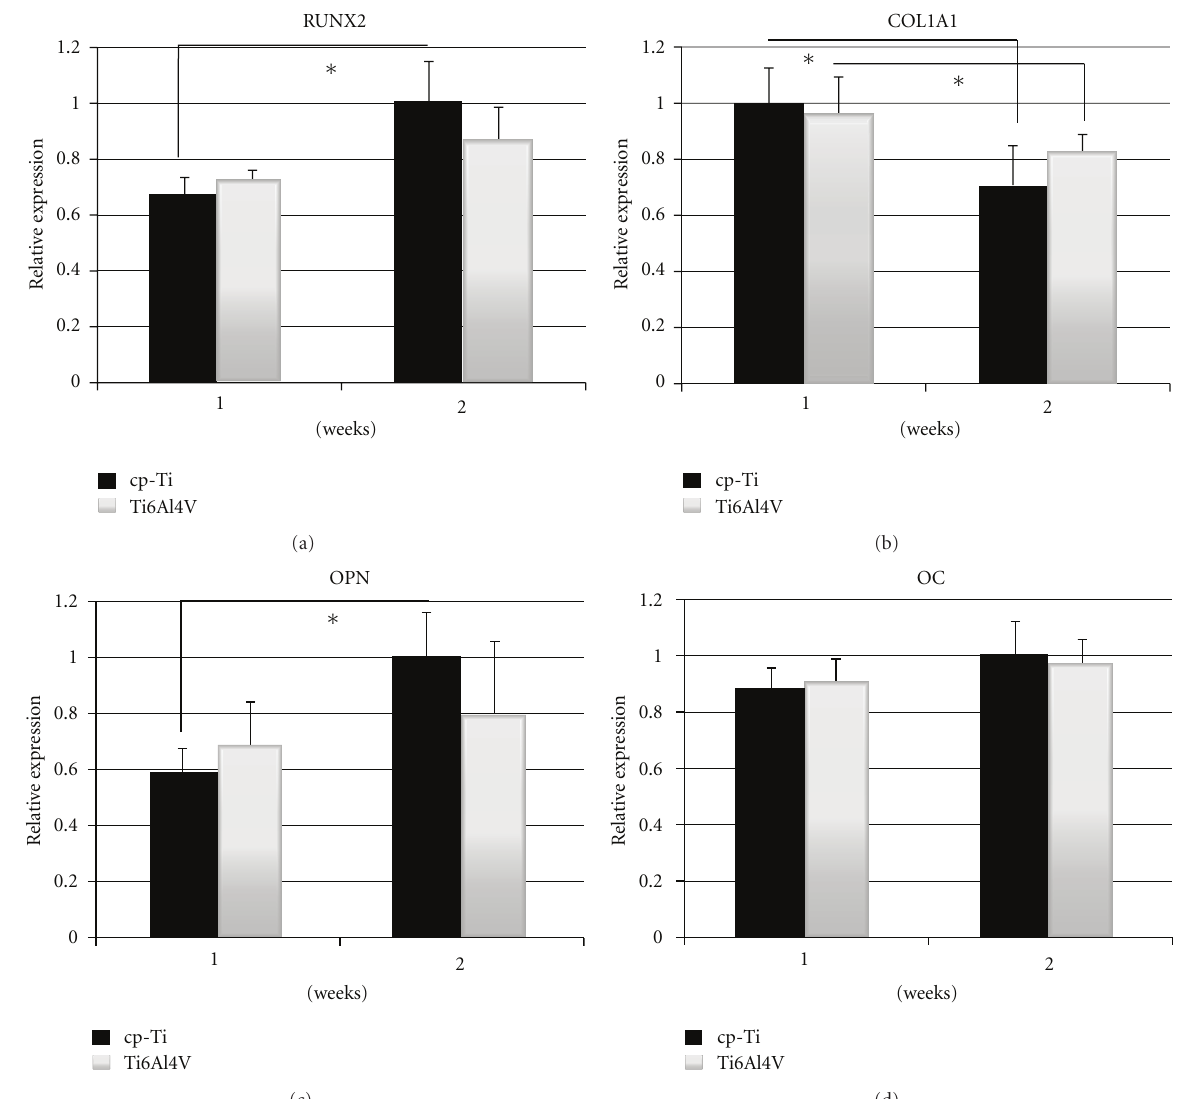
Figure 5: Real-time PCR results showing the expression of RUNX2 , COL1A1 , OPN , and OC after 1 and 2 weeks of culture for both constructs. Results are presented as relative expression values. A value of P < 0 . 05 was taken as significant di ff erence ( ∗